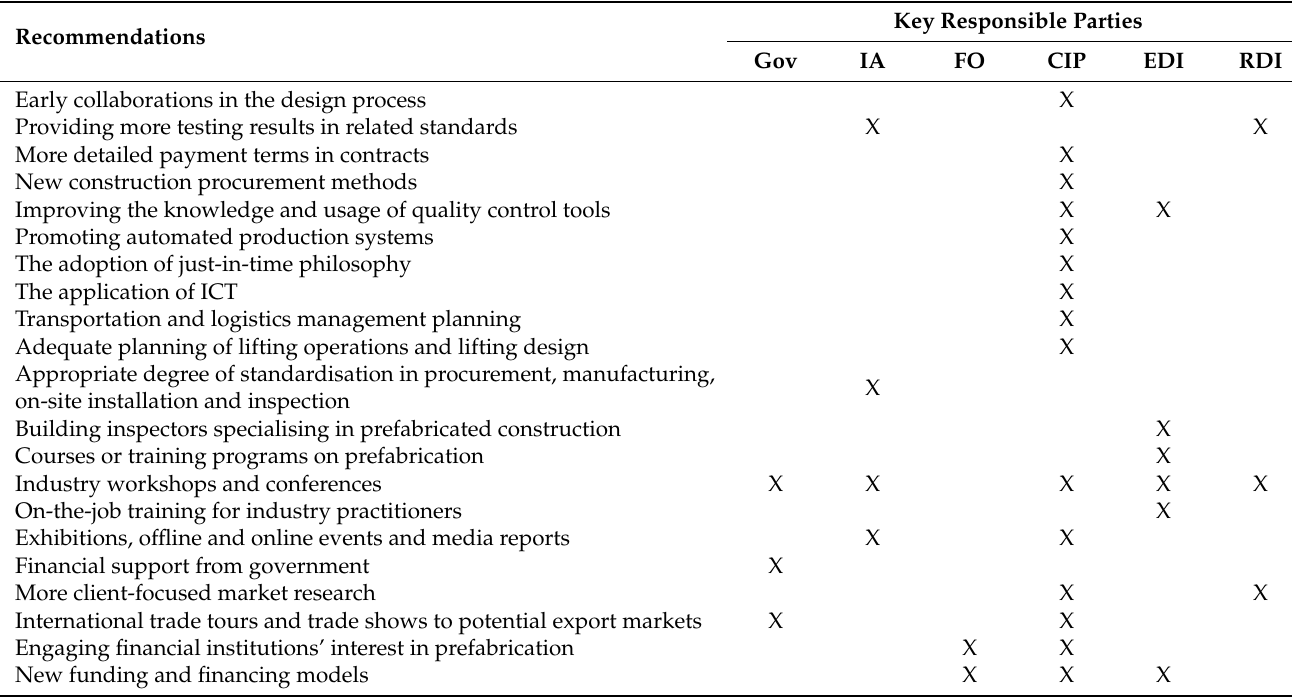
Table 7. Key responsible